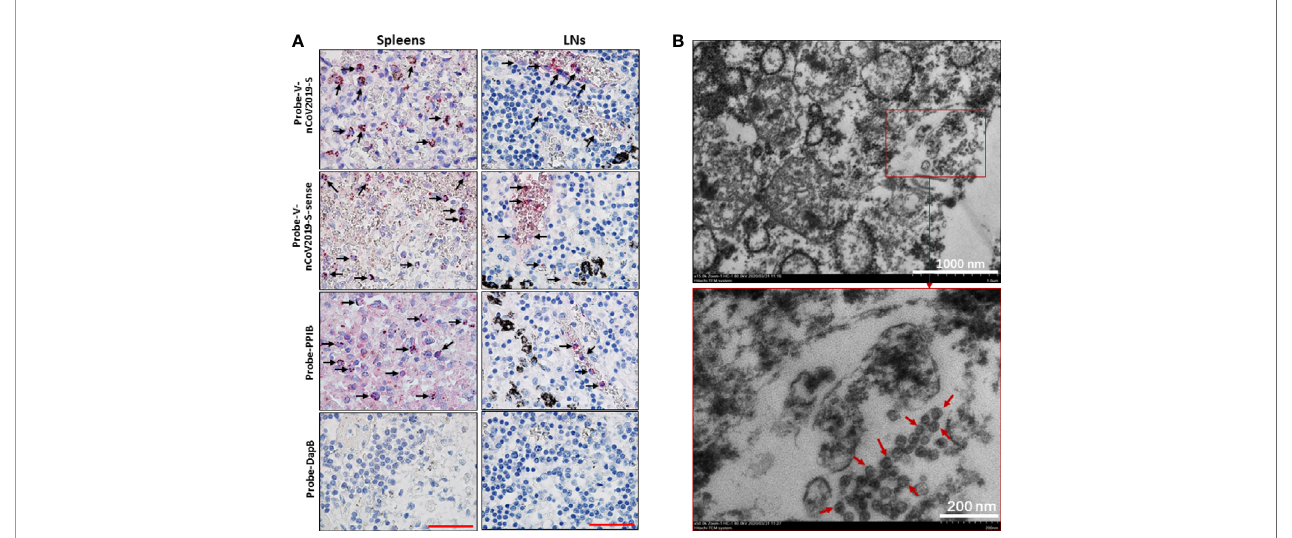
FIGURE 2 | SARS-CoV-2 was identi fi ed in spleens and LNs. The spleen and hilar LNs from one representative COVID-19 post-mortem case (case #2) were collected, (A) SARS-CoV-2 viral RNA was detected by RNA ISH, the positive reactivity for the housekeeping gene PPIB was used as positive control. Scale bar = 50 m M, arrow indicates positive cells. (B) TEM assay showed that some coronavirus-like particles with diameters of 50~100 nm were observed in hilar LNs. Arrows indicate coronavirus-like